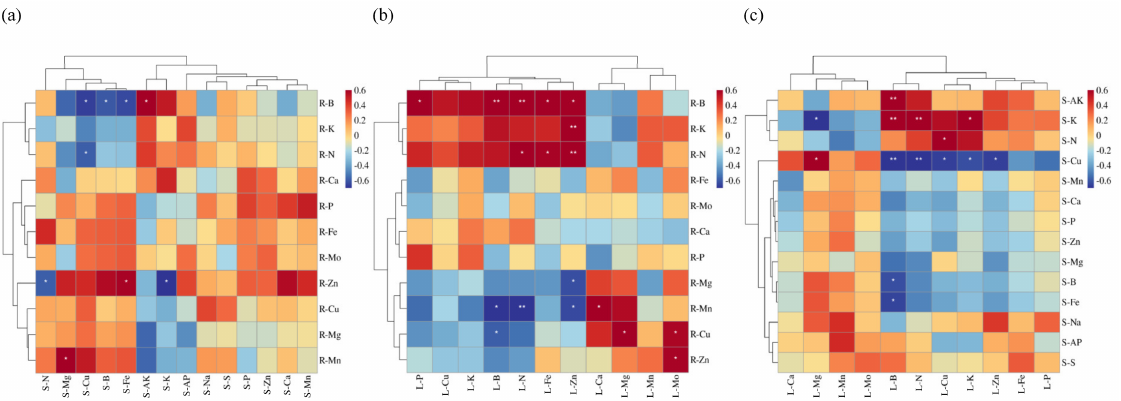
Figure 2. Clustering correlation heatmap with signs in various parts: ( a ) Soil (S) and root (R); ( b ) Root and leaf (L); ( c ) Soils and leaf. “**”: p < 0.01; “*”: p < 0.05.